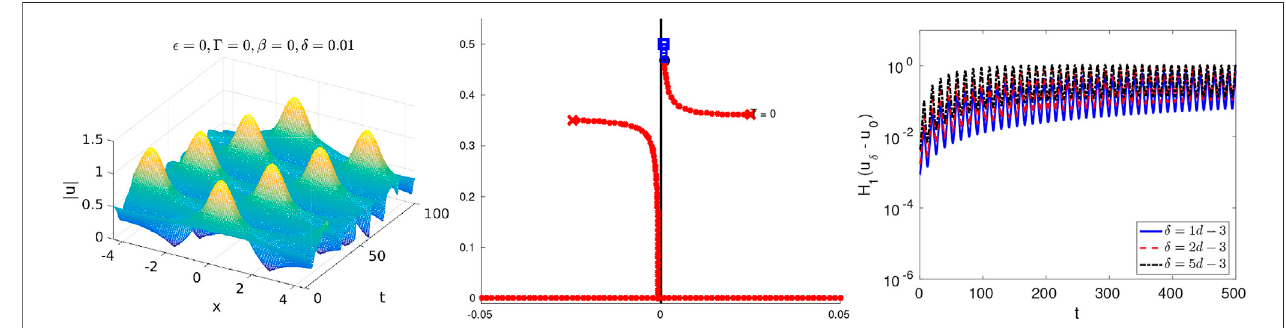
FIGURE 3 | NLS noneven 3-phase solution: (A) | u δ ( x , t )| for 0 ≤ t ≤ 100, (B) it ’ s spectrum at t (cid:1) 0, (C) η ( t ) for u δ ( x , 0 ) (cid:1) u 0 ( x , 0 ) + δ g 2 ( x )